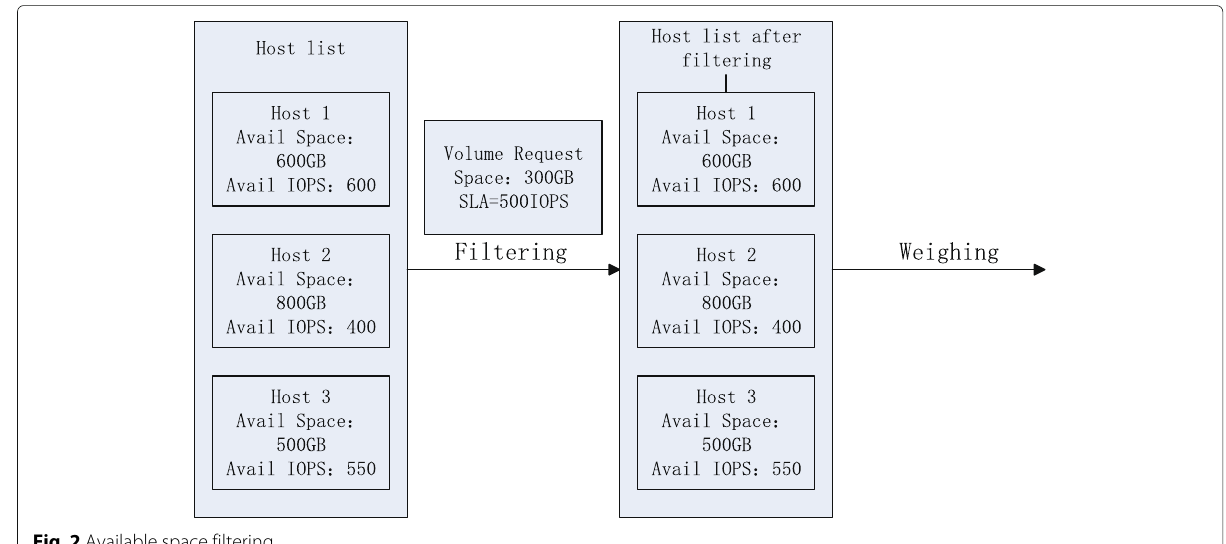
Fig. 2 Available space